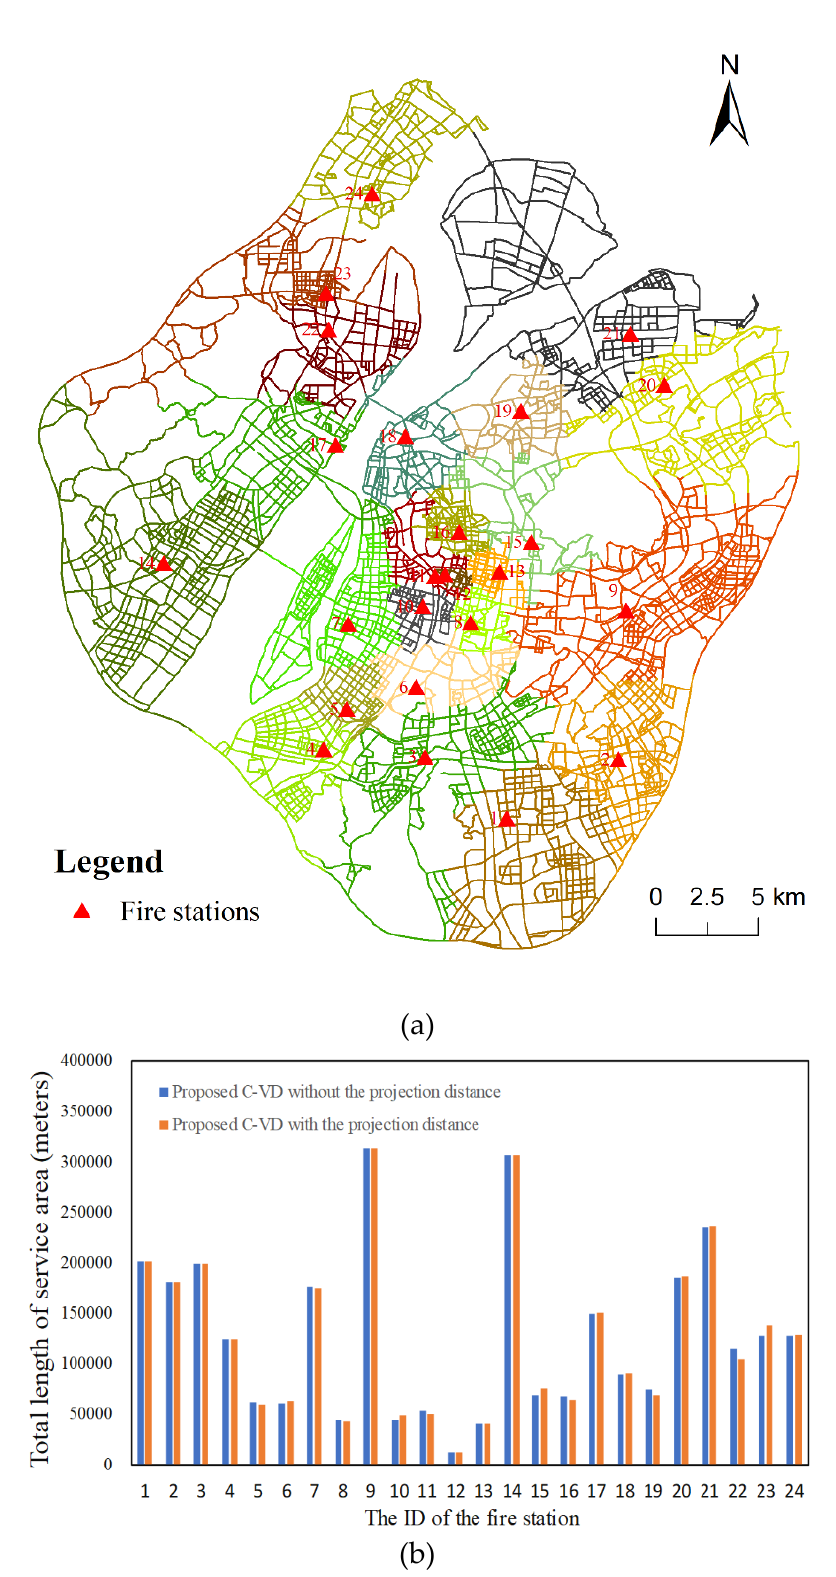
Figure 16. The result of service area delimitation of fire stations using the C-VD with projection distance ( a ) and the difference between the results constructed without projection distance and with projection distance ( b ).